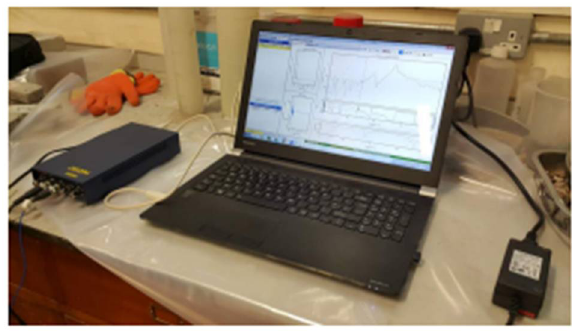
Figure 15. DATS modal analysis suite.